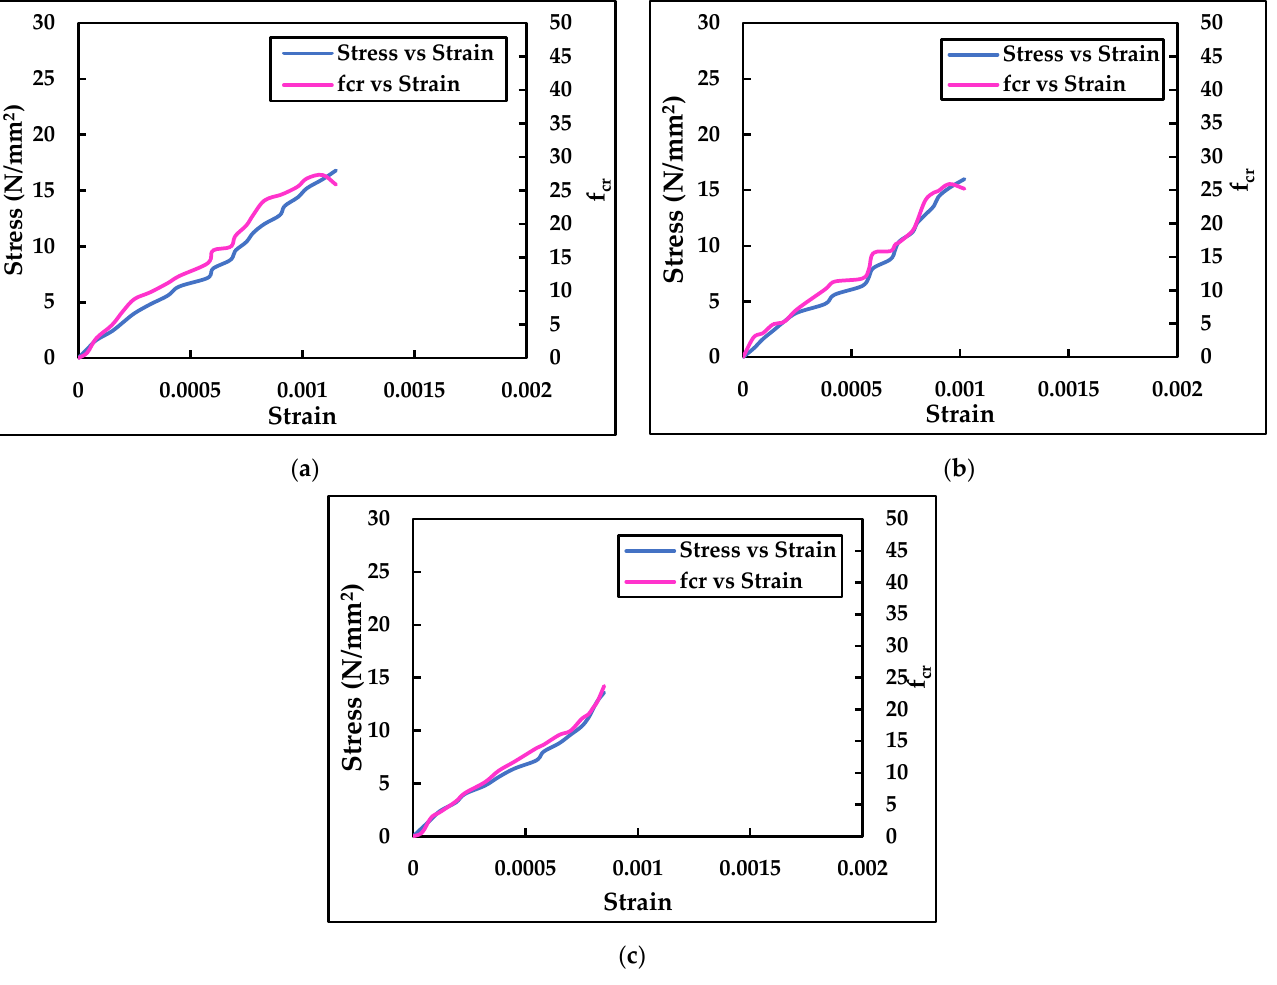
Figure 11. Graphical illustration of stress vs. strain and f cr vs. strain after 28 days of air curing. ( a ) 95% brass fibre with 5% carbon fibre addition; ( b ) 90% brass fibre with 10% carbon fibre addition; ( c ) 85% brass fibre with 15% carbon fibre addition.